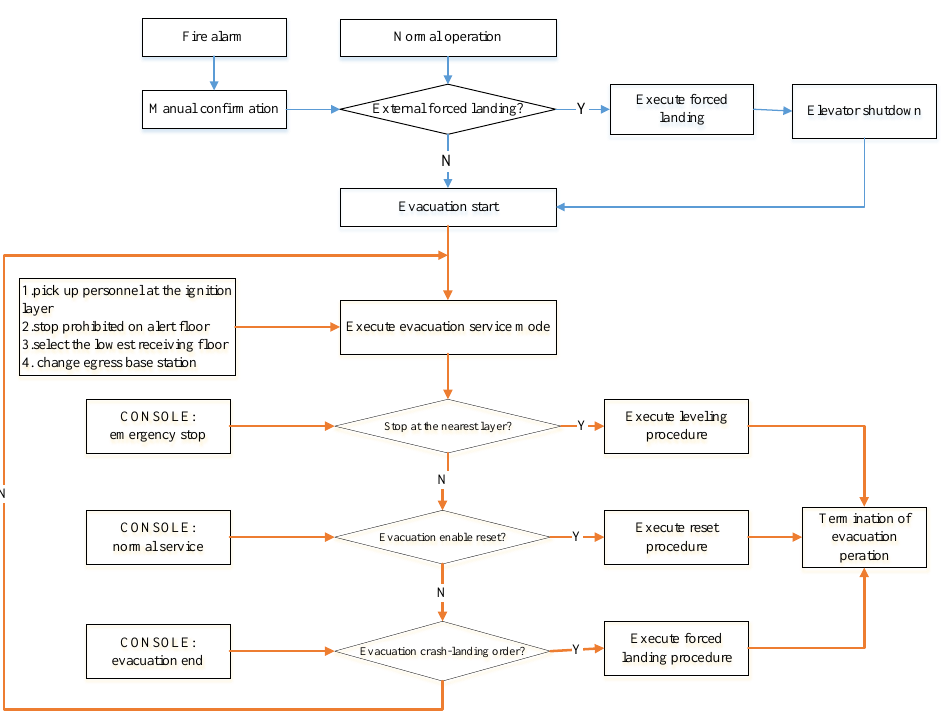
Figure 12. Elevator fire evacuation .